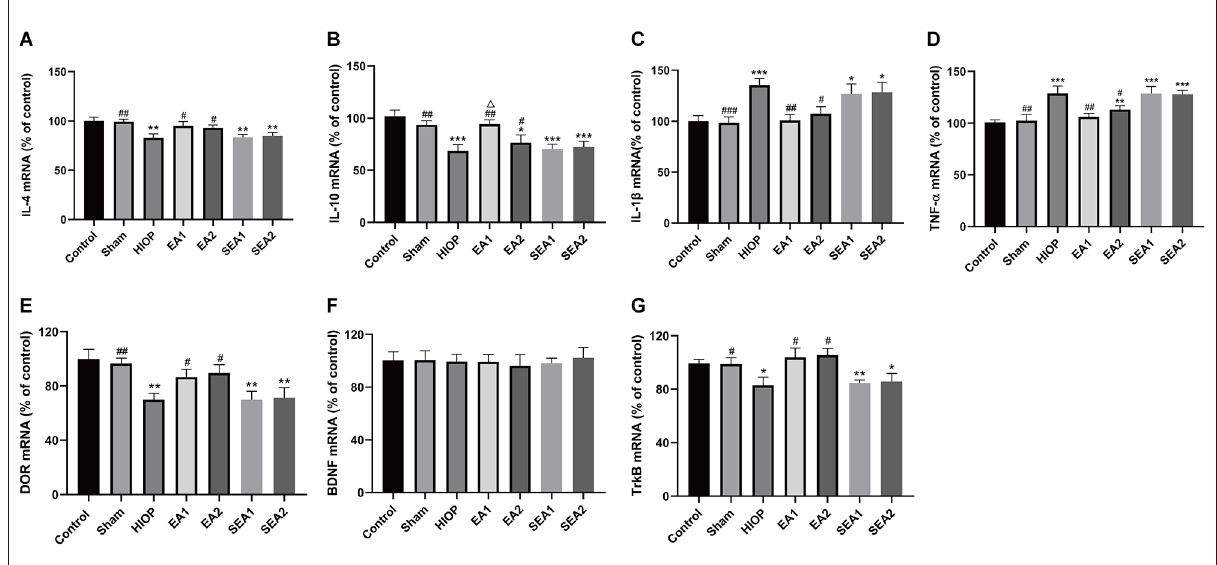
FIGURE4 EA can activate DOR and elevate DOR and TrkB expression to reduce the inflammatory response at 1 day of RIRI. (A–D) The mRNA expression levels of proinflammatory cytokines (TNF- α and IL-1 β ) and anti-inflammatory cytokines (IL-4 and IL-10) were evaluated by RT–qPCR at 24 h of reperfusion following 1 h of retinal ischemia. (E–G) The mRNA expression levels of DOR, BDNF, and TrkB were evaluated by RT–qPCR at 24 h of reperfusion following 1 h of retinal ischemia. The data are expressed as the mean ± SEM ( n = 6 for each group; * P < 0.05, ** P <